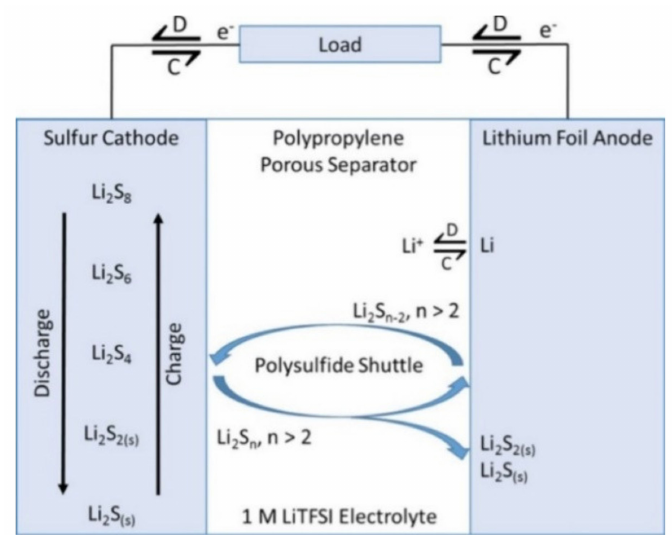
Figure 5. Schematic diagram of a Li–S cell structure with charge/discharge operations. Adapted